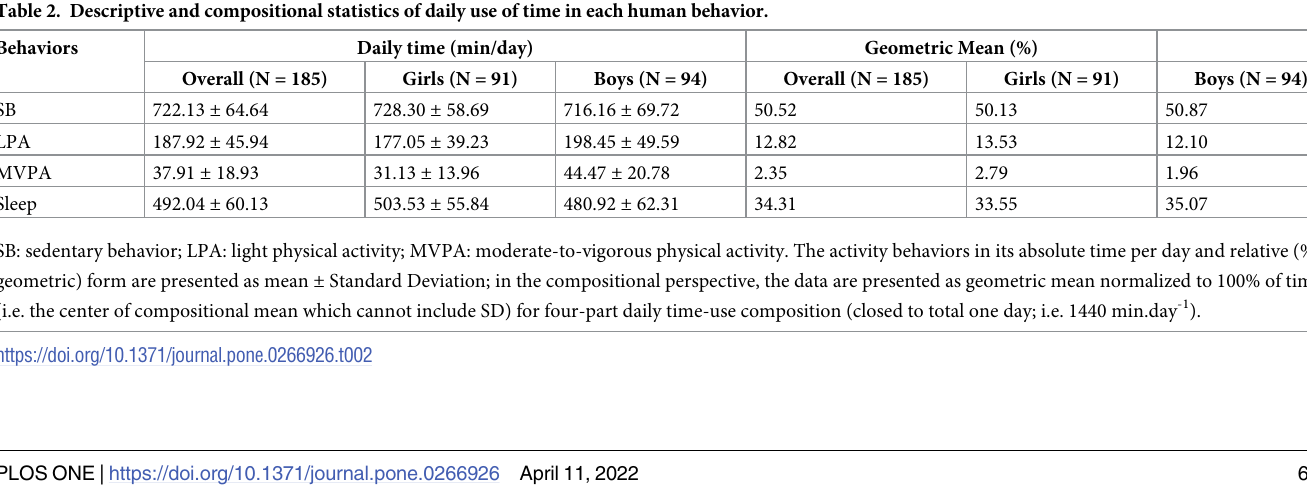
(Fig 2C). There were no differences between sexes to meet ST recommendations Table 2 presents the compositional statistics of the four parts of the daily time use behaviors (absolute and relative value). Standard and normalized statistics in accordance with the com- positional paradigm for 1440 min/day are also presented. The normalized geometric mean for